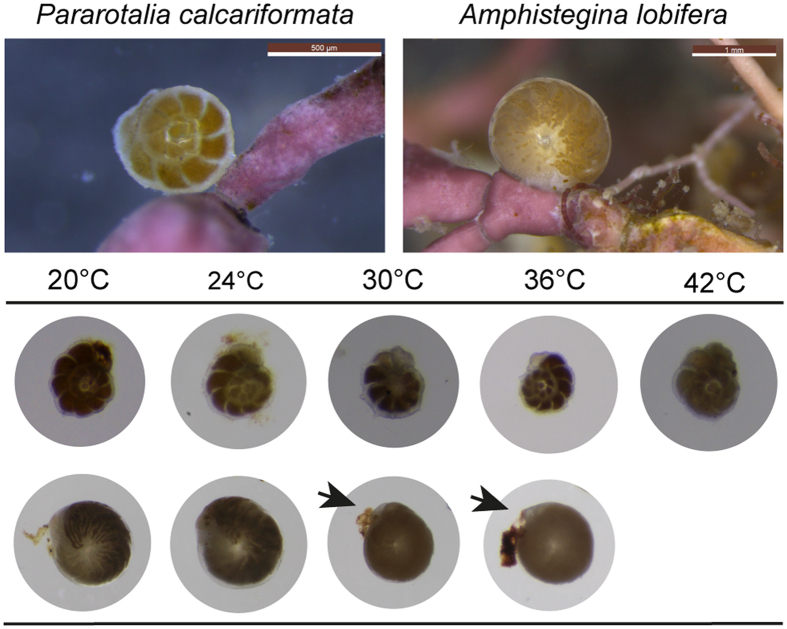
Microscopic images of the species Amphistegina lobifera and Pararotalia calcariformata.Images show specimen with healthy symbiont coloration in its natural habitat in comparison to healthy and bleached specimens after the exposure to manipulative experiments for two weeks, arrows indicated symbiont loss in A. lobifera at temperatures >30 °C.